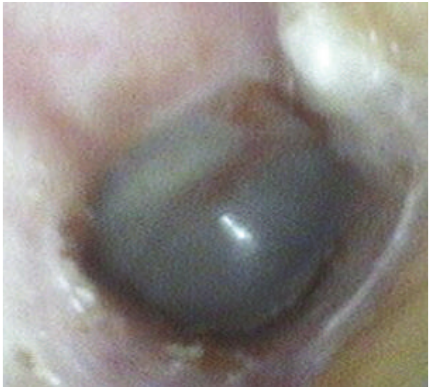
Figure3:ThefinalpostoperativeresultshowsanintactEACwithout evidence of tumor